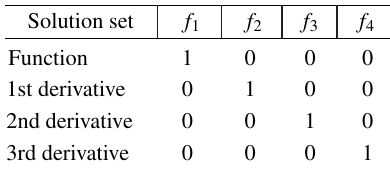
Table 2. Initial values: derivatives of normed fundamental solutions at x ◦ = 0